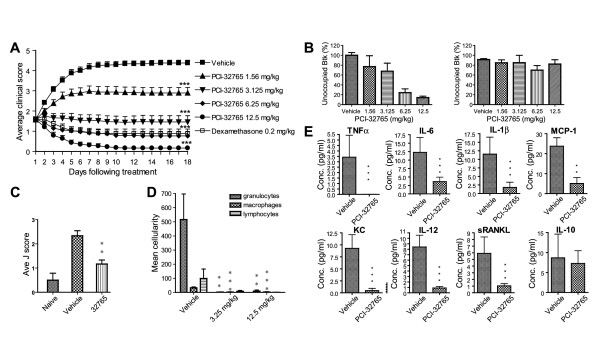
PCI-32765 dose-dependently inhibits inflammation, bone erosion, cellular infiltration and synovial fluid cytokines/chemokines in CIA models. (a) Mice (n = 12) were treated with PCI-32765 orally once daily. Daily average clinical scores are plotted over 18 days of treatment; *** P < 0.001 compared with vehicle (Mann-Whitney U-test). (b) Using the fluorescent probe PCI-33380 [19], the percentage of Btk occupied by PCI-32765 in collagen-induced arthritis (CIA) mice was measured in splenocytes collected at three hours (left panel, n = 6) and 24 hours (right panel, n = 6) following last dose (D18) of drug treatment. (c) Average J score was determined following micro-CT scanned reconstructed images of hind legs from CIA study (n = 6). (d) Average cellularity (n = 12) in synovial fluid from the knee of CIA mice following PCI-32765 treatment. Giemsa-Wright stained slides were enumerated for granulocytes, macrophages, and lymphocytes under 100×, and five random fields were scored and averaged. (e) Synovial fluid cytokine and chemokine levels from the 12.5 mg/kg treatment group (n = 12) are shown; * P < 0.05, ** P < 0.01; *** P < 0.001 compared with vehicle, analysis of variance.